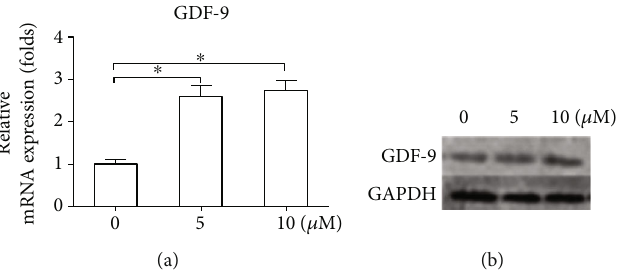
Figure 6: LY2109761 upregulates the expression of GDF-9. Keloid-derived fi broblasts were treated with increasing doses of LY2109761. (a) Relative mRNA expression levels of GDF-9 as determined by qRT-PCR. (b) Representative western blots showing protein expression of GDF- 9. ∗ P < 0 : 05 between LY2109761 groups and DMSO control; ∗∗ P < 0 : 05 between LY2109761 5 μ M and 10 μ M treatment